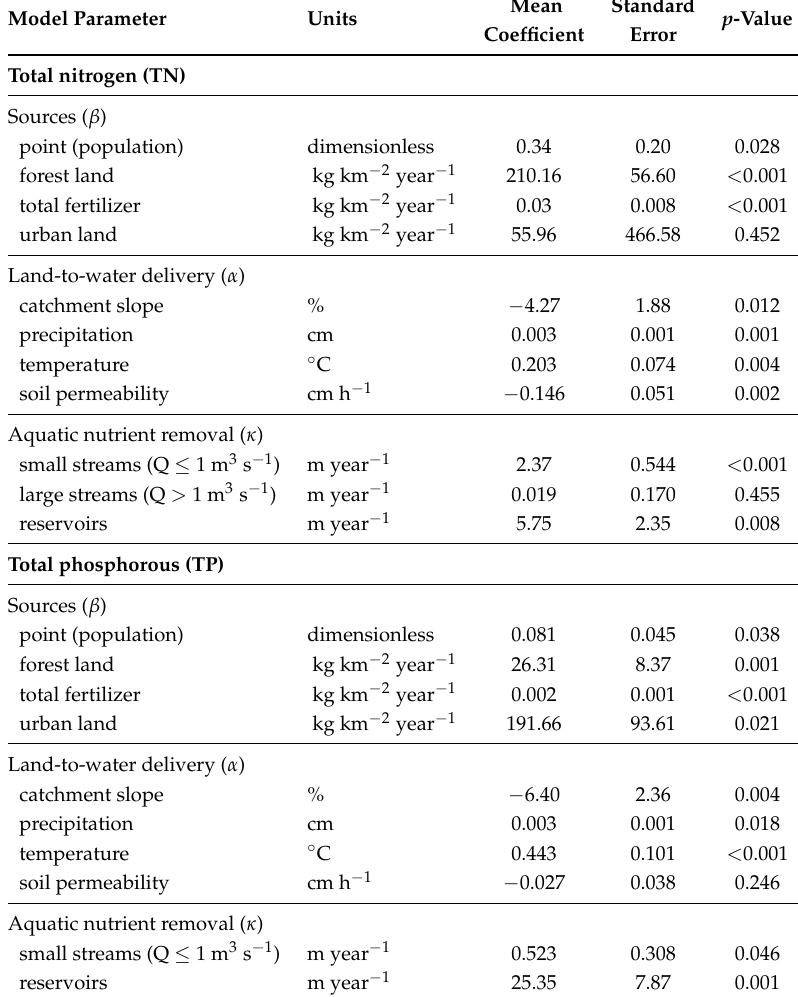
Table 1. SPARROW model calibrated parameters for total nitrogen (TN) and total phosphorus